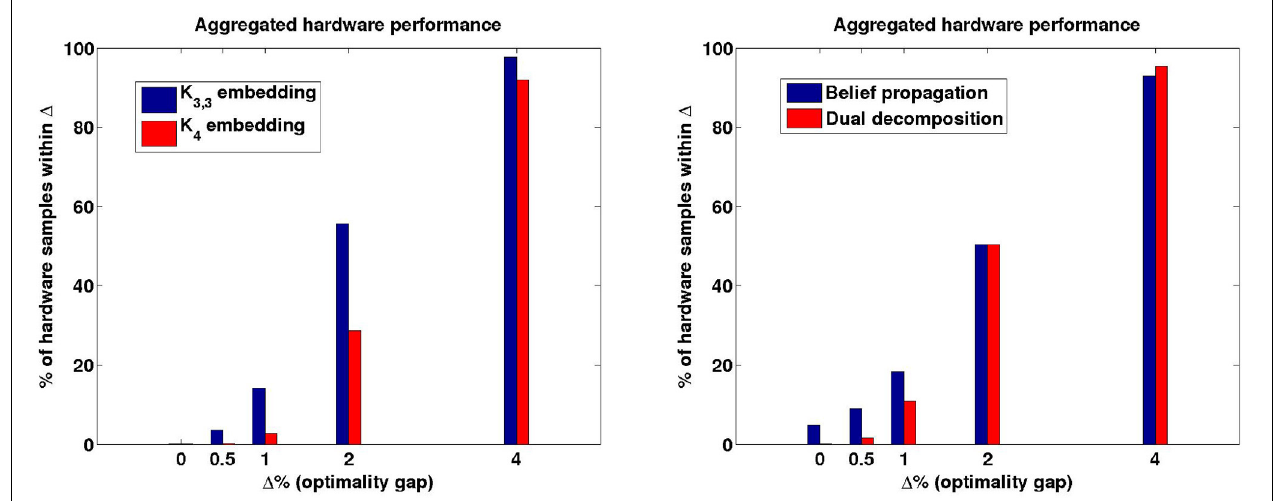
FIGURE 3 | Hardware performance aggregated over all regional subproblems. (cid:10) is the relative error of a solution returned by the hardware compared to the true optimal value of the Ising